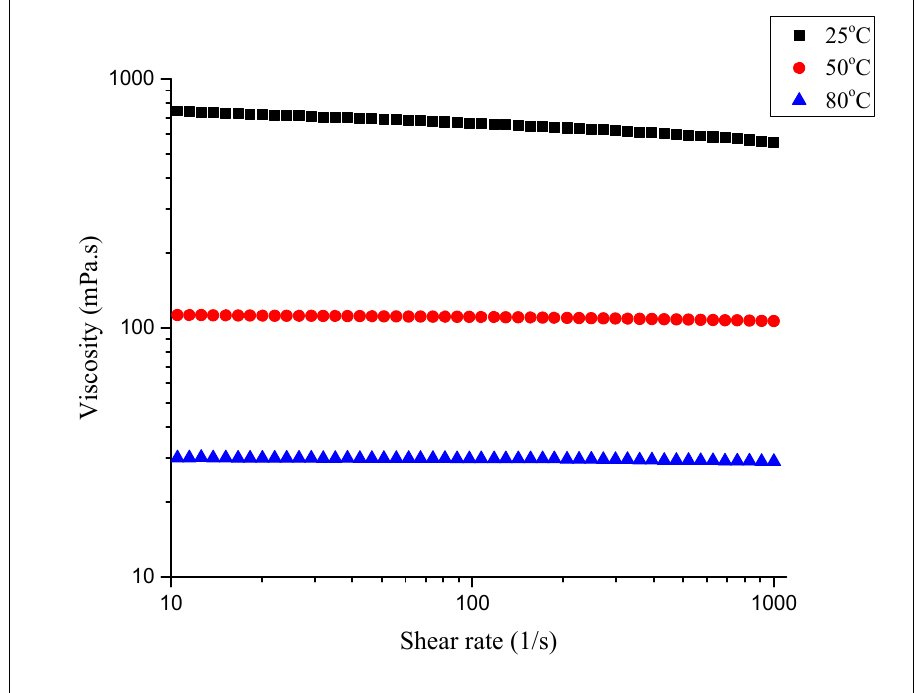
Figure 3. Viscosity of JOLE, as a function of shear rate at 25, 50, and 80 °C.